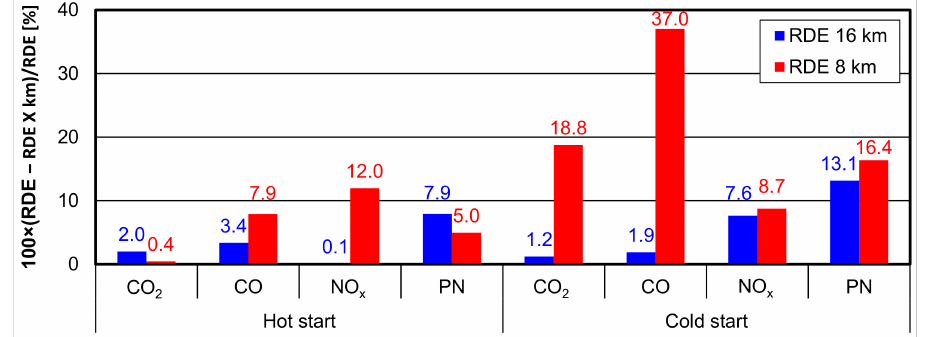
Figure 9. Relative difference of emission values (average values) for cold and hot start during RDE 16 km and RDE 8 km tests compared to RDE-Compliant test (RDE X km stands for RDE 16 km or RDE 8 km